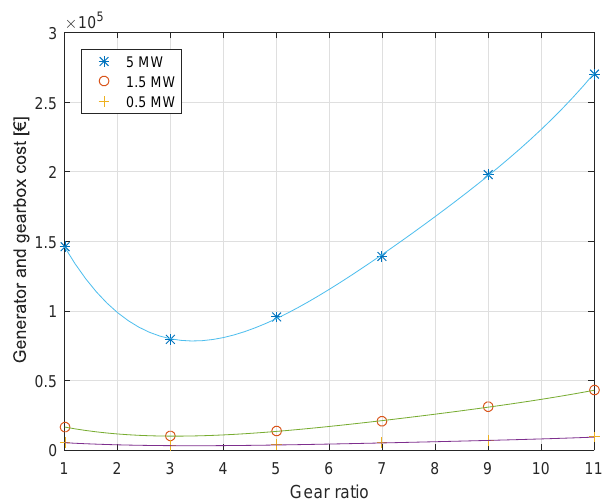
Figure 13. Tidal stream turbine (TST) estimated cost for different gear ratios and different power ratings.